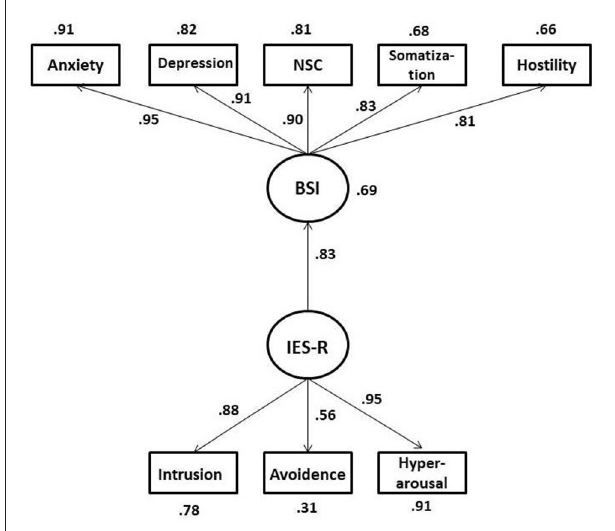
FIGURE 1 | Structural model depicting the effects of Impact of Events Scale-Revised (IES-R) scores on Brief Symptom Inventory (BSI) Scores.